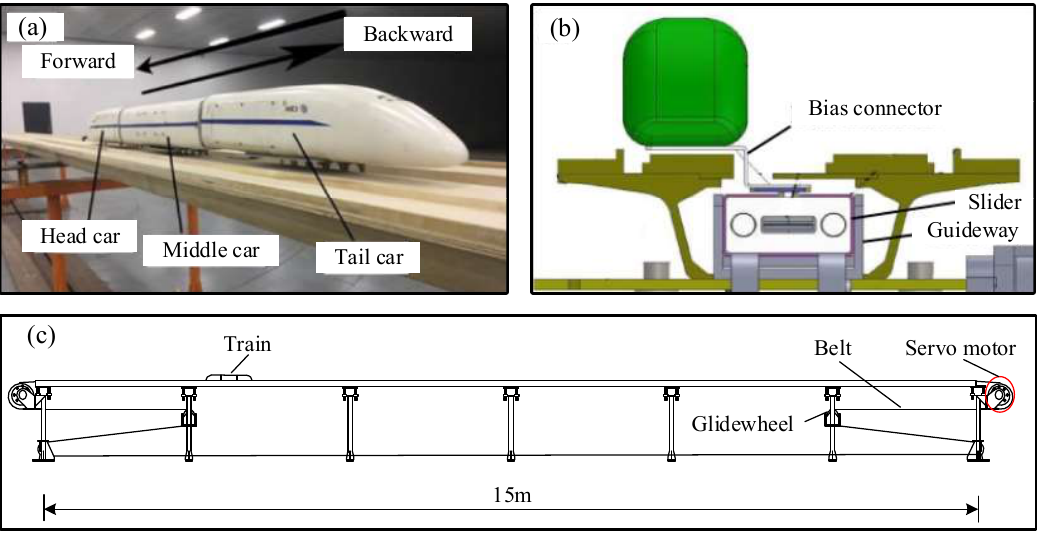
Figure 4. Diagram of a moving train wind tunnel test: ( a ) a moving train model arrangement; ( b ) side view of model details; ( c ) general layout of the test system.